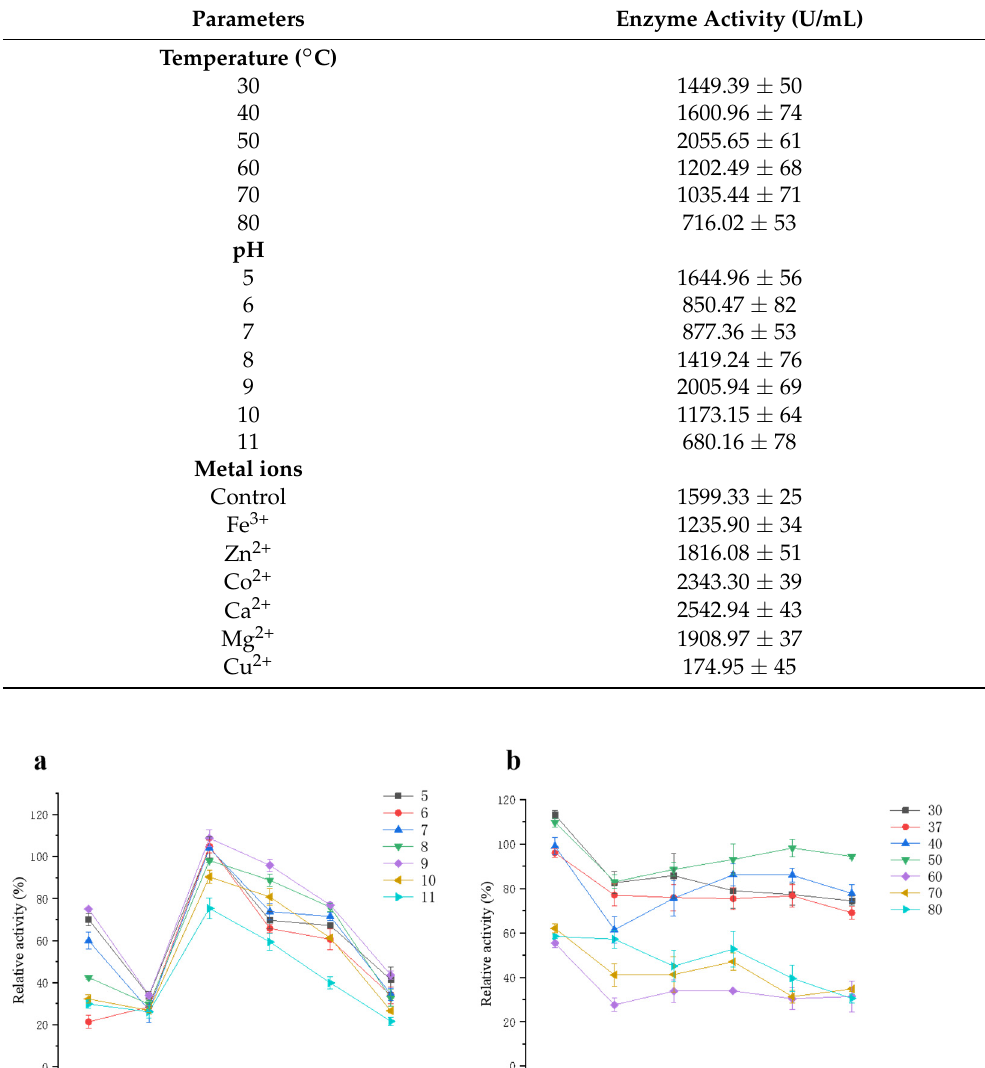
Table 3. Effect of temperature, pH, and metal ions on recombination collagenase activity.